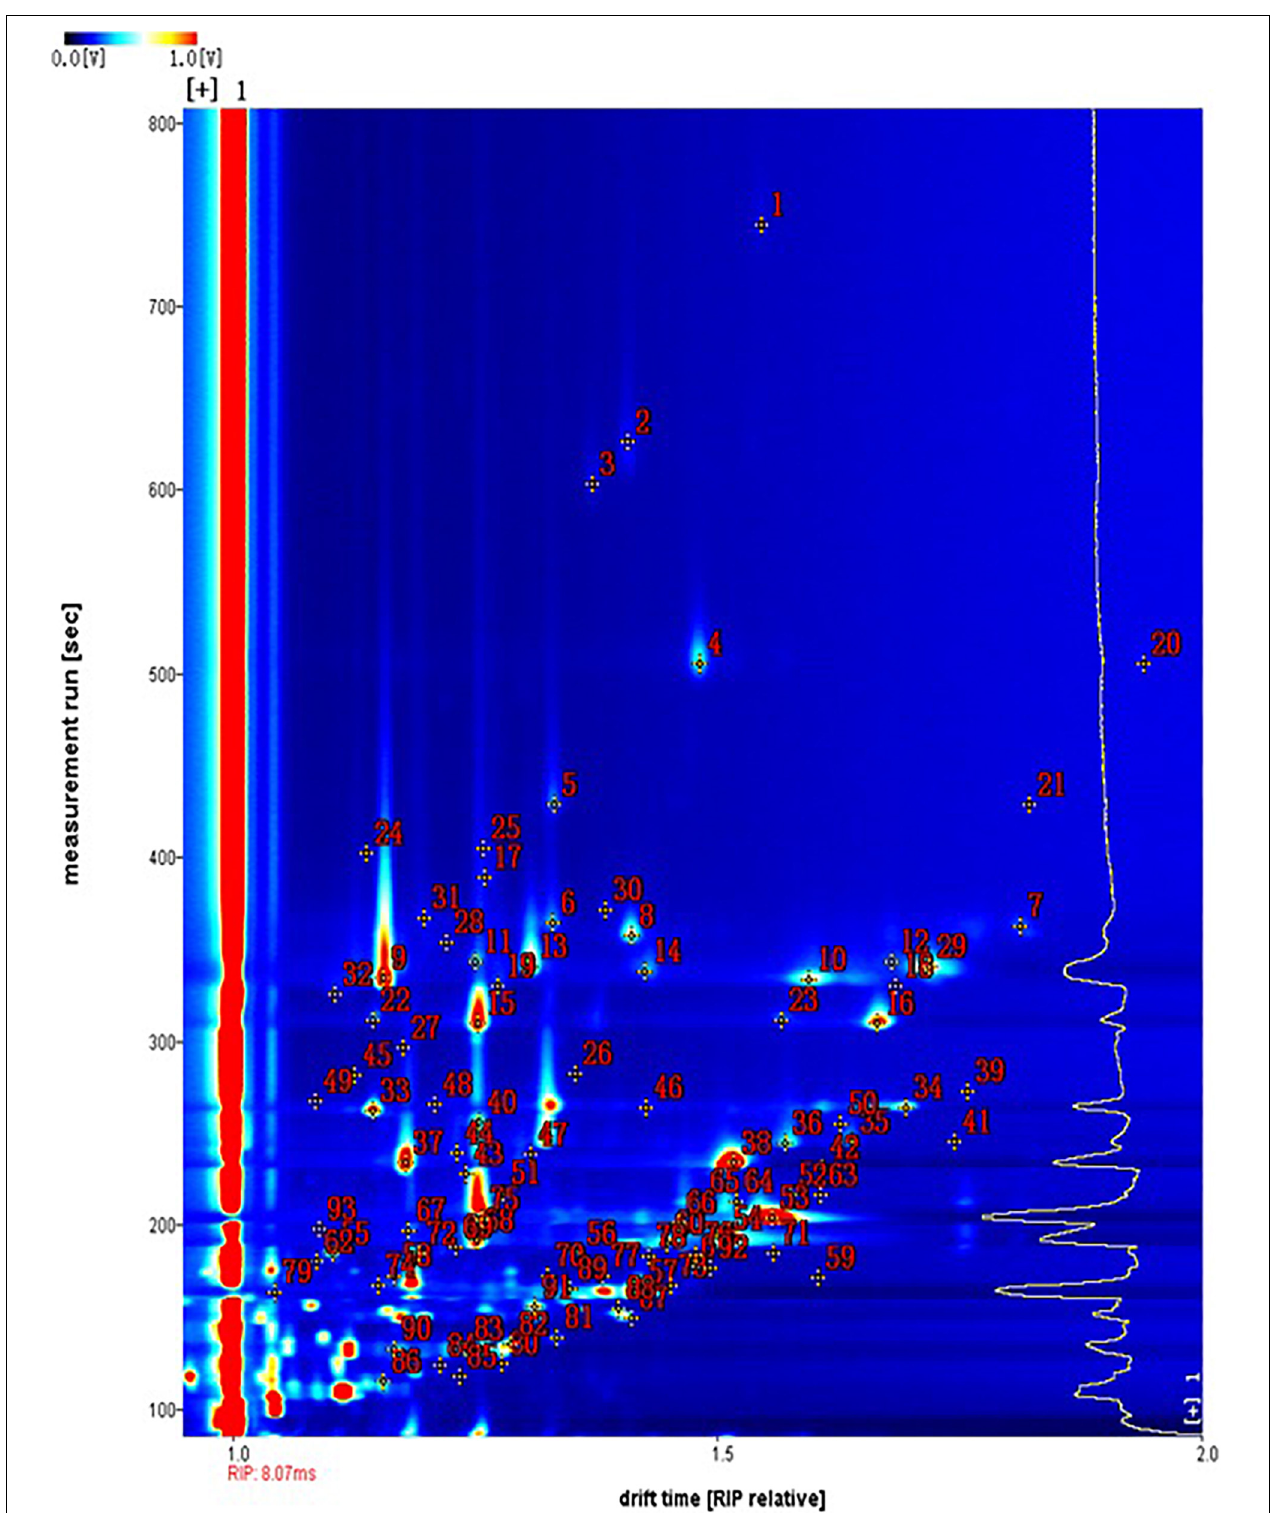
FIGURE 2 | The topographic plots of gas chromatography-ion mobility spectrometry (GC-IMS) spectra obtained from 30 vegetable soybean cultivars. The numbers 1–93 correspond to the detected signals, with those identified listed in Table 2 and the other numbers representing unidentified signals.